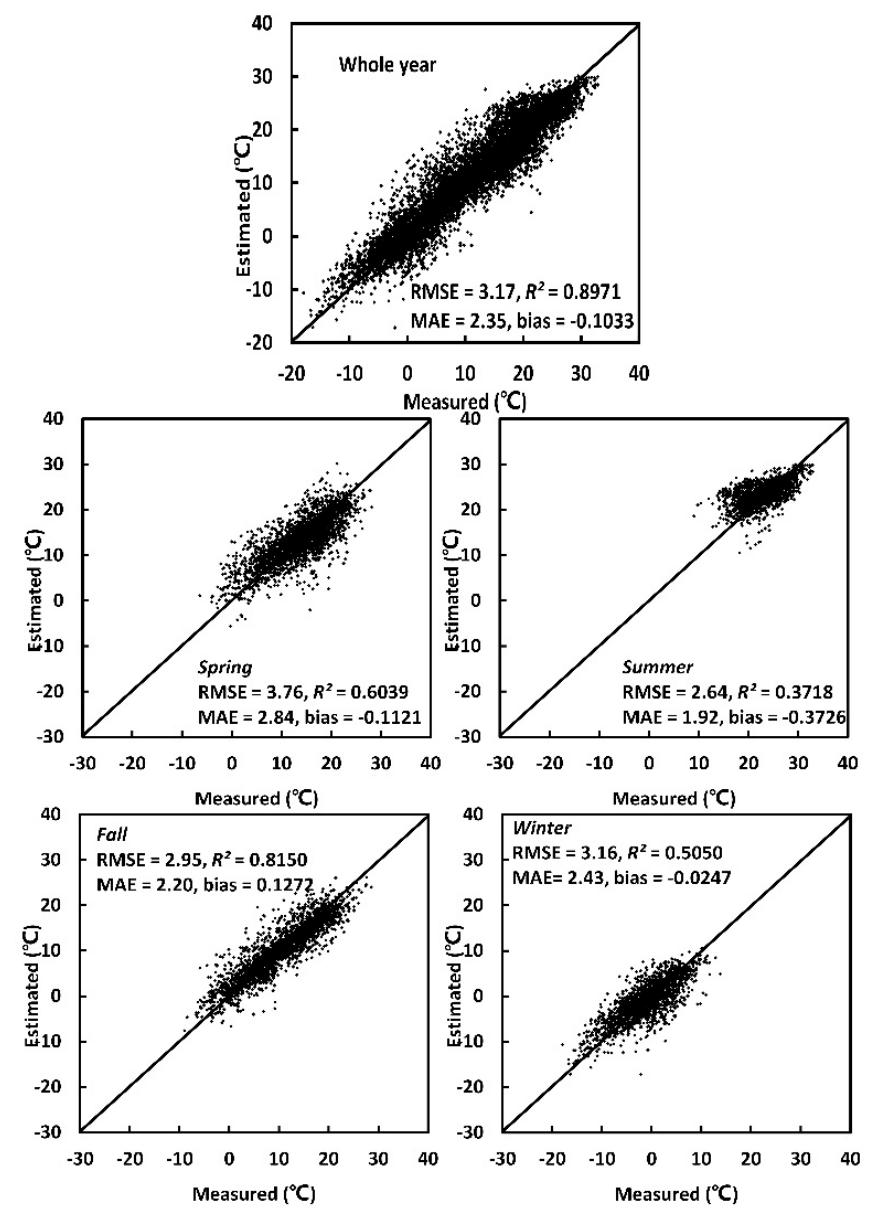
Figure 11. Relationships between the estimated and measured daily mean air temperature ( TA ) for whole-year data and for data from the spring, summer, fall, and